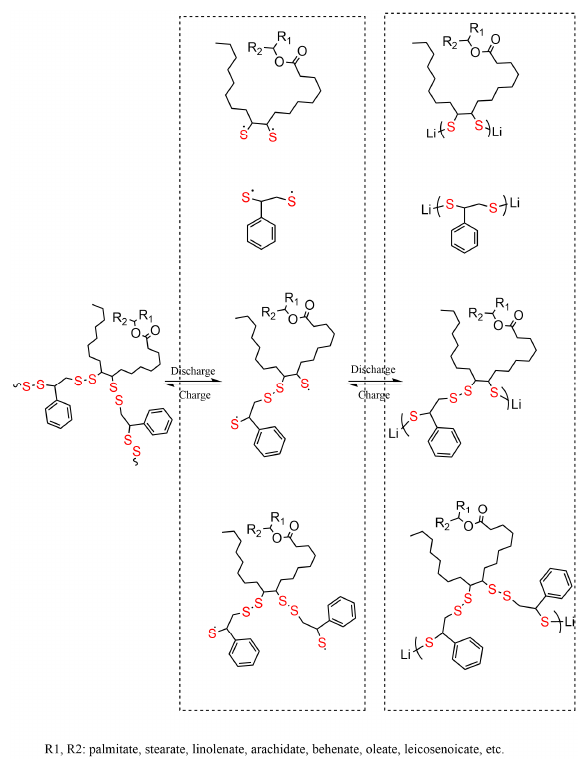
Figure 10. The reactions involved during the charge and discharge process.